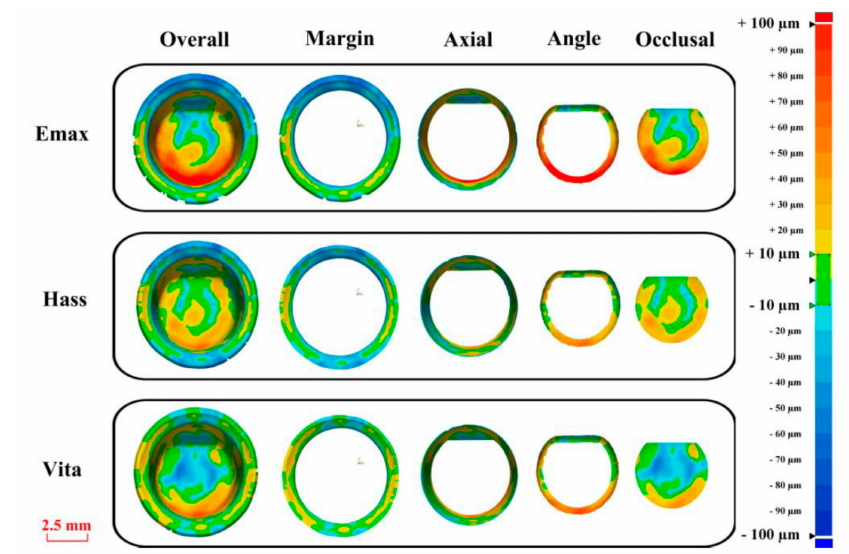
Figure 4. Comparison of color di ff erence maps for di ff erent lithium disilicate blocks.